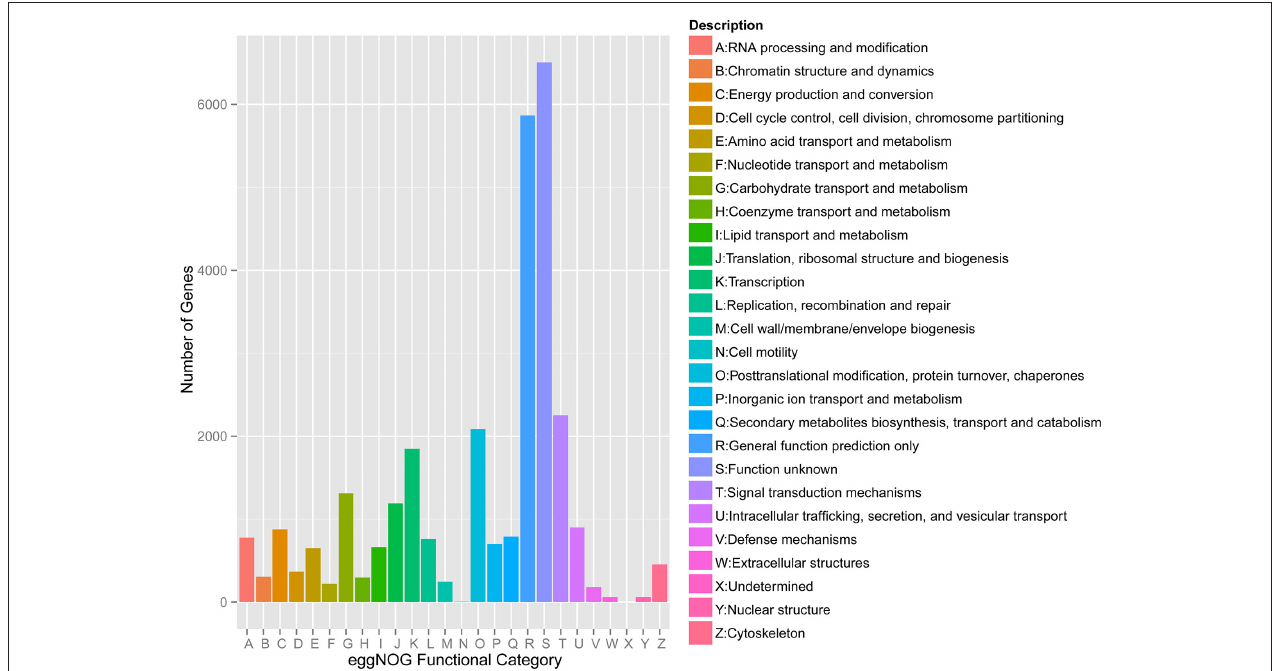
FIGURE 3 | Number distribution of eggNOG annotation of Unigenes related to A-Z.